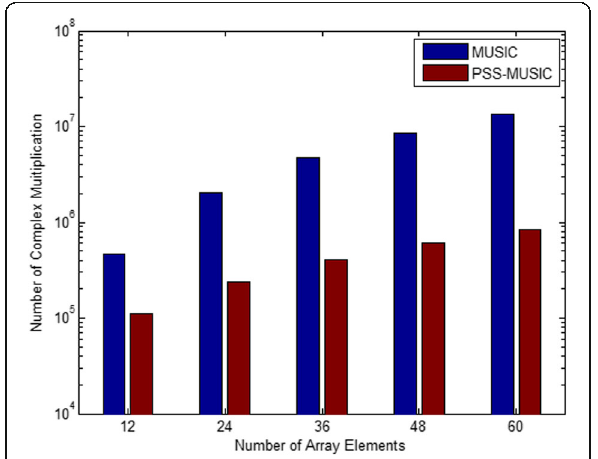
Fig. 9 Number of complex multiplications versus number of array elements. It depicts the number of complex multiplications versus number of array elements